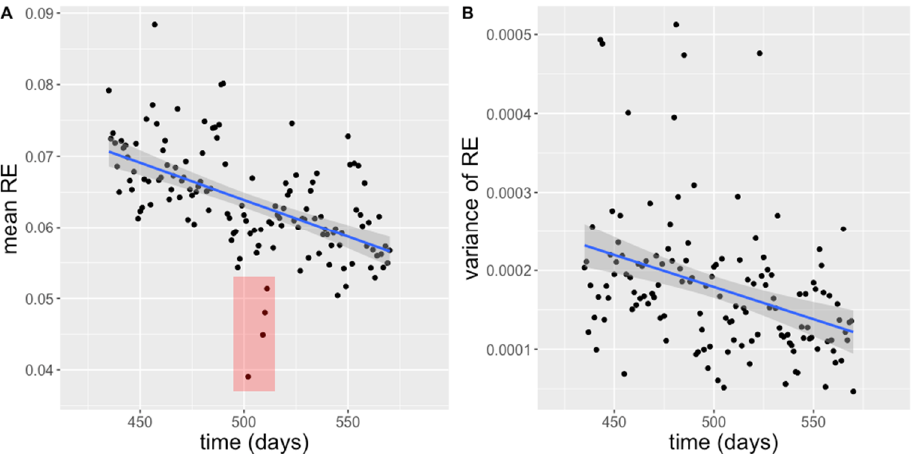
Figure 5. ( A ) Mean roaming entropy (RE) for 19 mice in the SNE over time with the change of the corresponding variance ( B ). The red area marks outliers in the values of the RE. The cRE increased to an average 8.654 ± 0.928 (CV = 10.7%, max = 10.716, min = 7.359, n = 19) over the time of 136 days (F (1|134) = 129100, p < 0.0001, adj. R 2 = 0.99). In contrast to the variance of the RE, the variance of the cRE also increased over time (F (1|134) = 3342, p < 0.0001, adj. R 2 =